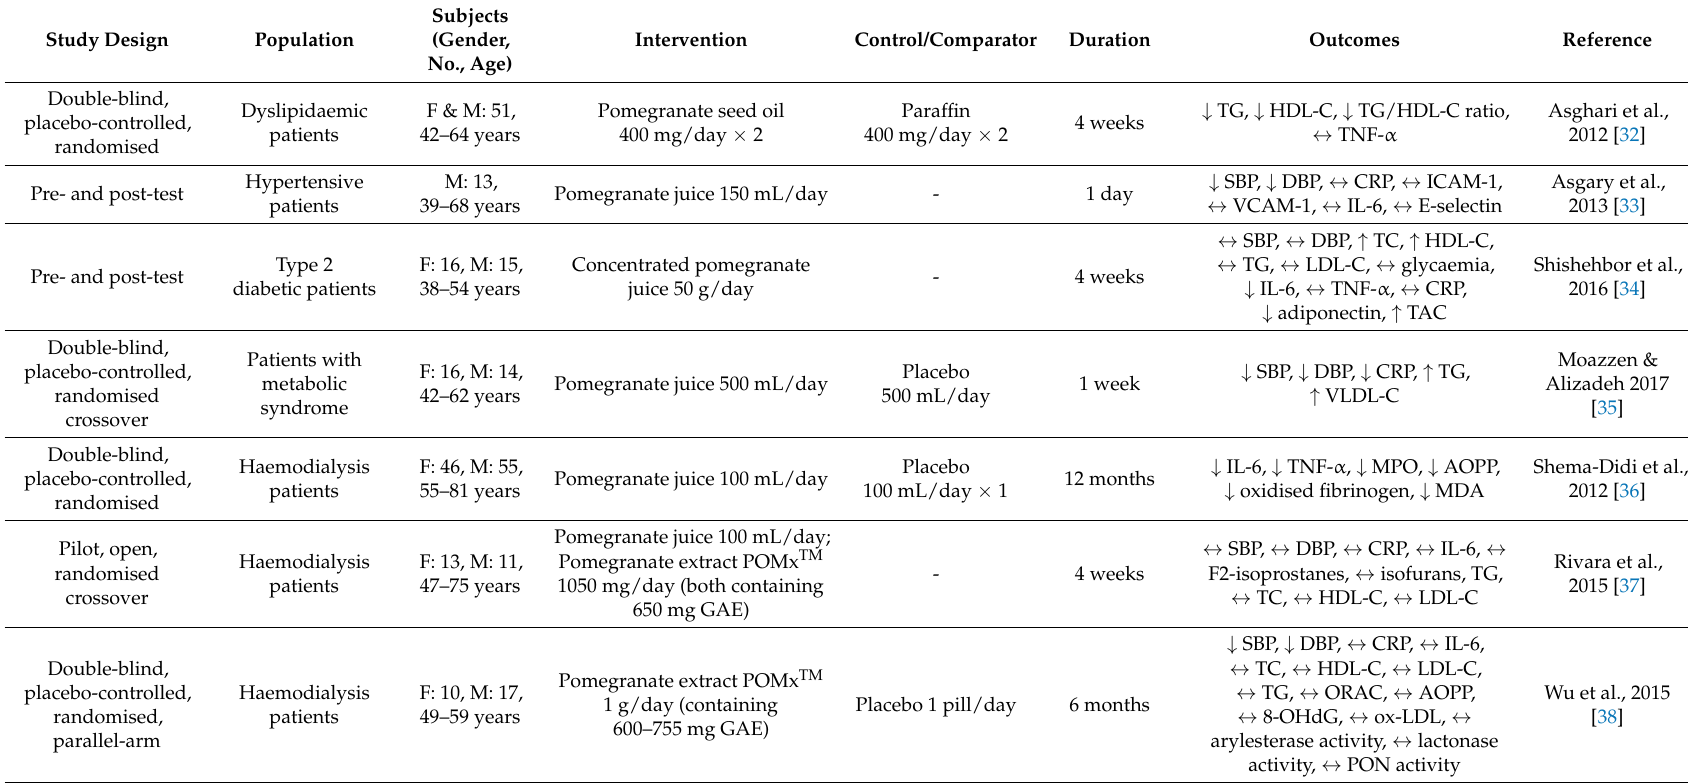
Table 2. Summary of findings related to pomegranate products consumption and CID in